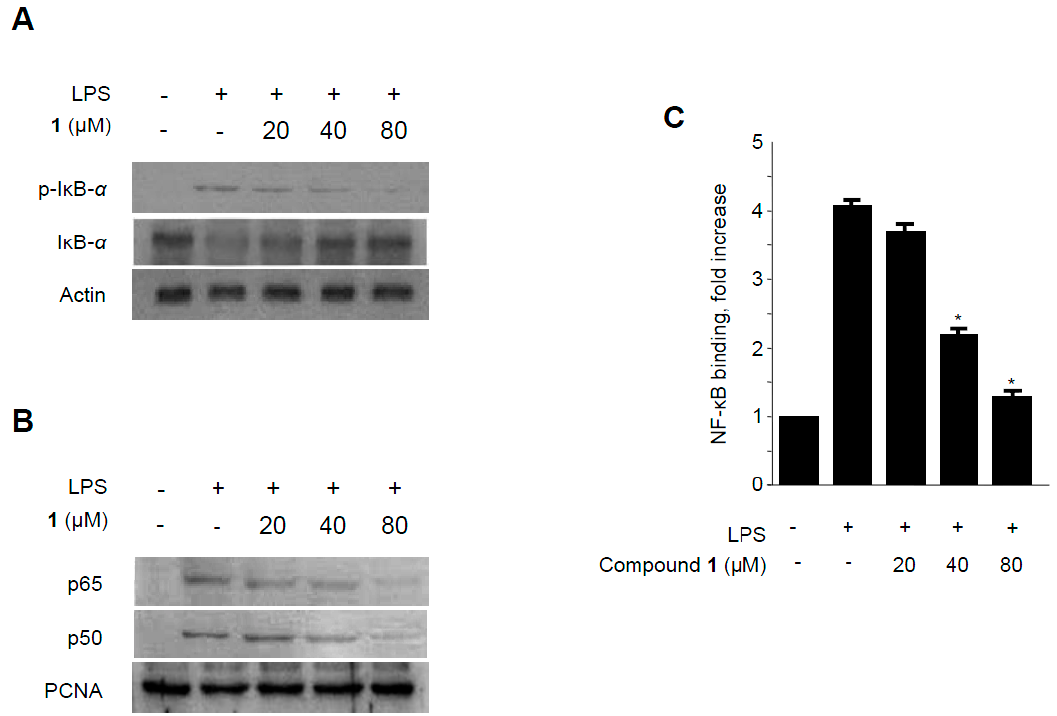
Figure 7. Effects of methylpenicinoline ( 1 ) on LPS-induced NF- κ B activation in